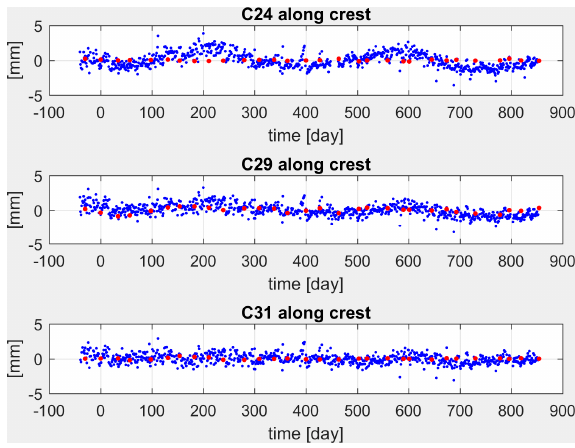
Figure 7. Displacements observed on ashlars 24 ( top ), 29 ( center ), 31 ( bottom ) by pendulums (red dots) and GNSS (blue dots) in the along-crest direction from October 2014 to April 2017.